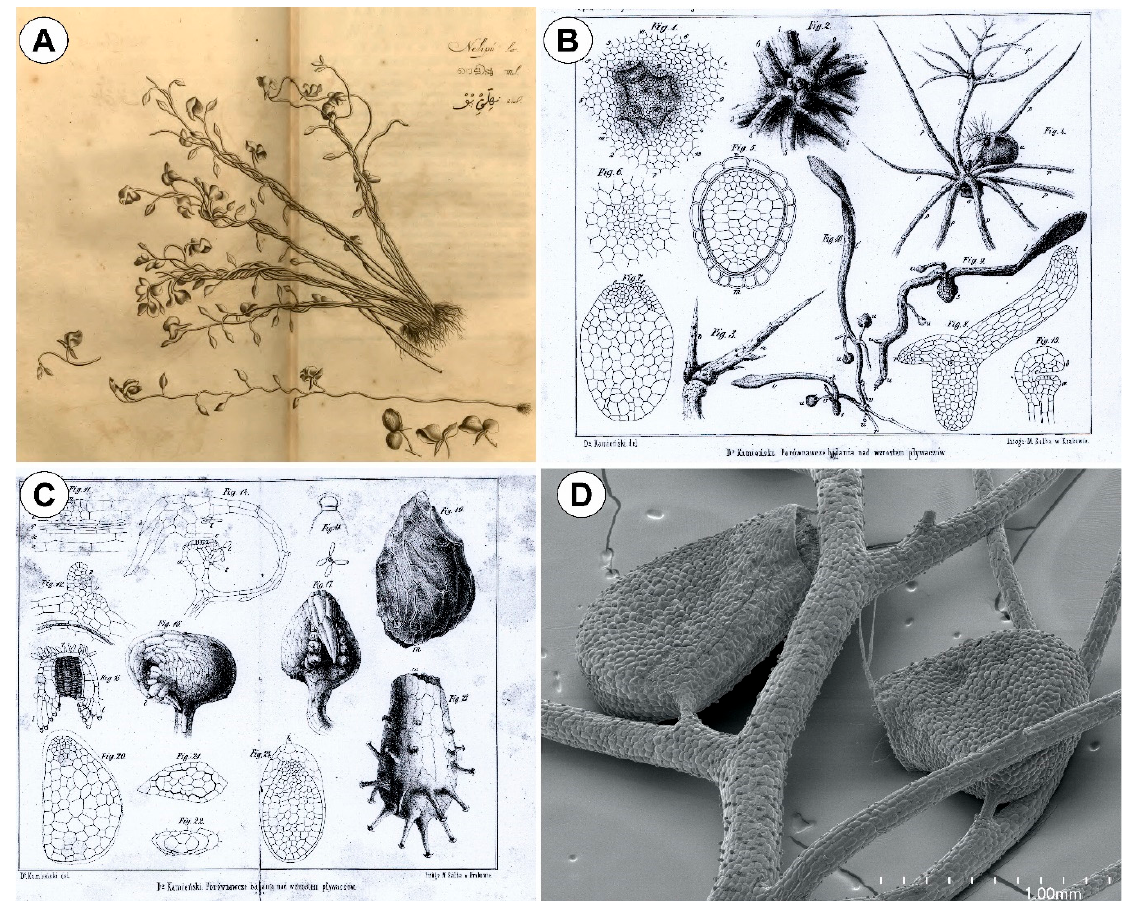
Figure 1. ( A ) One of the earliest records of Utricularia made by Hendrich van Rheede tot Draakenstein (1636–1691) in his Hortus Malabaricus (1689). According to Taylor [20], this is Utricularia reticulata Sm., a species with twining inflorescences, a “common weed of rice cultivation”. ( B , C ) Scanned figures from Franciszek Kamie ń ski’s study which described in detail seed structure, seedlings, and traps of Utricularia species [34]. ( D ) The aquatic Utricularia aurea [35] with two traps by SEM (scanning electron microscopy–image by Bartosz J. P ł achno).